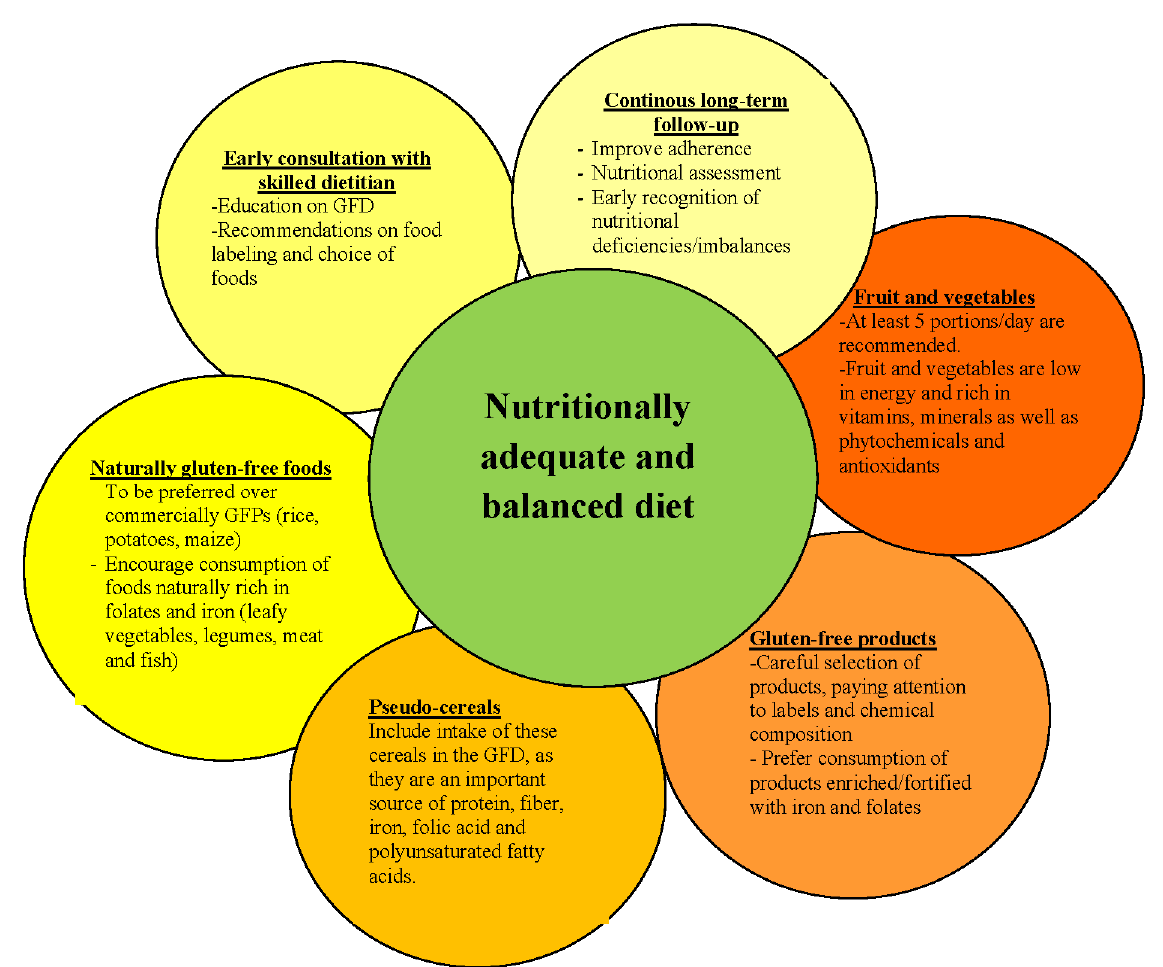
Figure 1. Schematic representation of proposed approach to a nutritionally adequate and balanced gluten-free